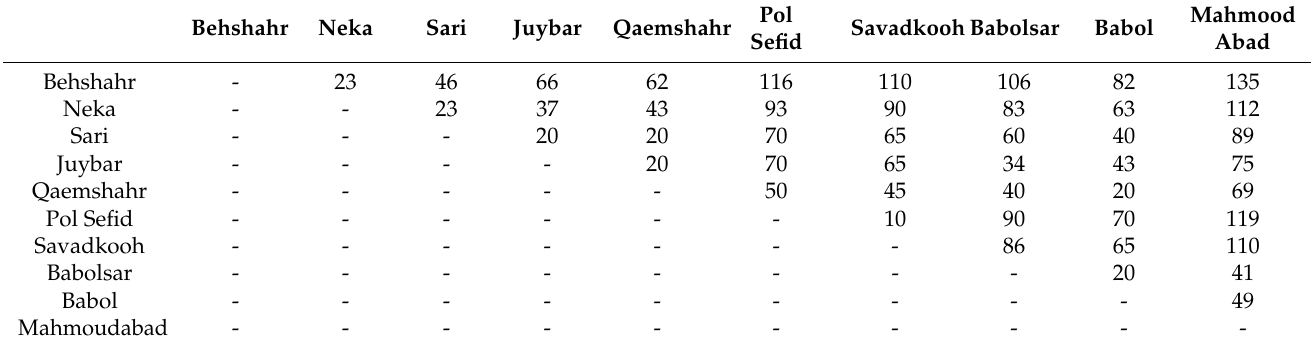
Table A4. Distance between mentioned cities of Mazandaran province (KM).